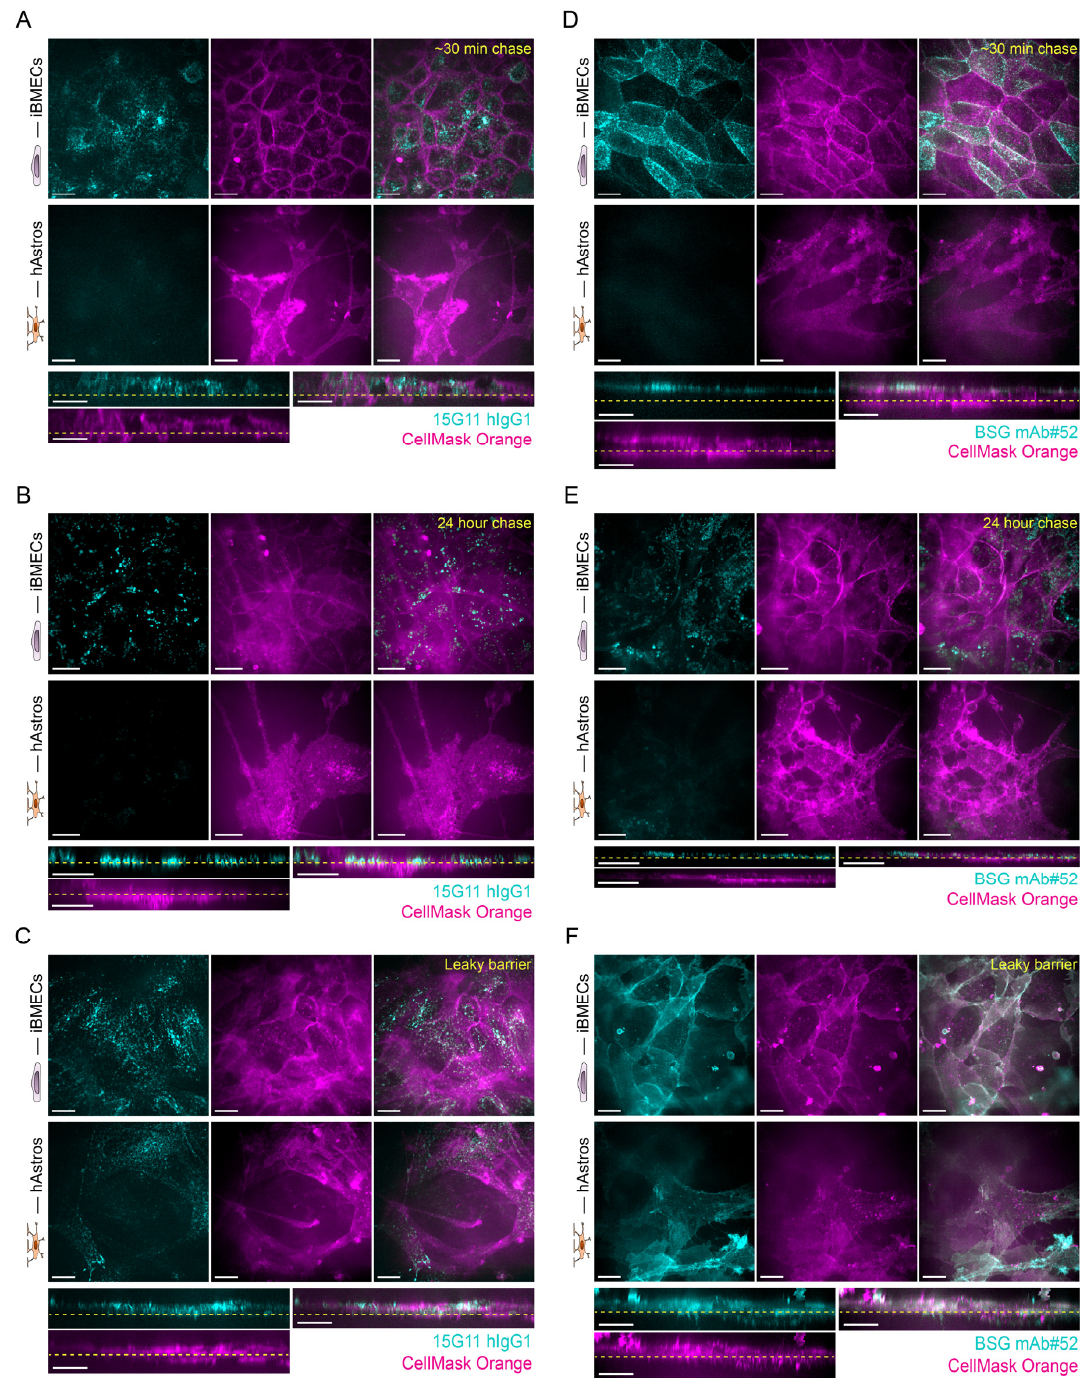
Figure 5. Transcytosis of Alexa Fluor 647 prelabelled high-affinity bivalent 15G11 hIgG1 and BSG mAb#52 across the µSiM-iBMEC model. Representative maximum intensity images and cross-sectional views showing the uptake of the 15G11 ( A – C ) and BSG mAb#52 ( D – F ) (cyan) in iBMECs and hAstros; the latter corresponds to the transcytosed mAbs. The apical side of the co-culture was exposed to Alexa Fluor 647 labelled 15G11 (500 nM) or BSG mAb#52 (100 nM) for 2 h or 10 min, respectively. The images represent the 30 min ( A , D ) and 24 h ( B , E ) chase times. Both iBMECs and hAstros were stained with 7.5 µ g/mL CellMask Orange plasma membrane dye (magenta). The iBMECs formed a tight barrier in subfigures ( A,B,D , E ), whereas the barrier was leaky in subfigures ( C , F ). Scale bars represent 20 µ